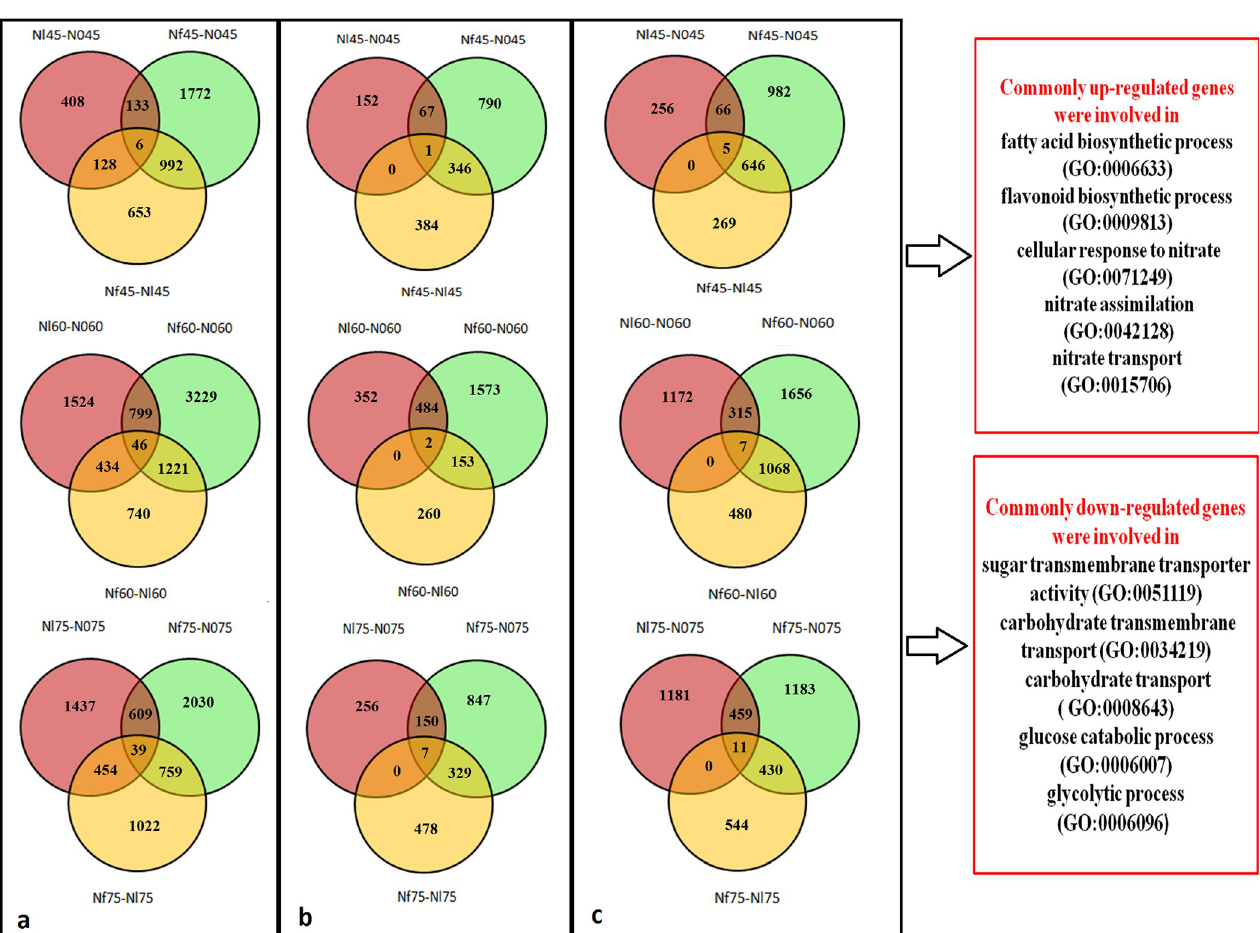
Fig 5. Venn diagram of the number of genes in the Nf-N0 (N0 compared to Nf), Nf-Nl, and Nl-N0 groups at 45, 60, and 75 days after transplanting (DAT). (a) All differentially expressed genes (DEGs), (b) upregulated DEGs, (c) downregulated DEGs. https://doi.org/10.1371/journal.pone.0273495.g005 The topGO enrichments showed that the biological processes “phosphate ion transmem- brane transport” and “phosphate ion transport” were the most abundant functional groups enriched by downregulated DEGs in N0 vs. Nf at 45 and 75 DAT as well as in Nl vs. Nf at 45 DAT. The terms “response to chitin” and “phosphate ion transport” were obviously enriched by downregulated DEGs in N0 vs. Nf at 60 DAT, and at the same time, the terms “response to chitin”, “response to wounding”, “phosphate ion transport”, and “phosphate ion transmem- brane transport” were enriched in Nl vs. Nf by downregulated DEGs. In addition, at 75 DAT, the process “response to water deprivation” was enriched significantly by downregulated DEGs in Nl vs. Nf. Moreover, wounding and deprivation processes were downregulated under Nl treatment at 60 and 75 DAT, Furthermore, “glucose − 6 − phosphate transport” and “phos- phoenolpyruvate transport” were enriched by upregulated DEGs under N0 treatment at 45 DAT. The term of “transcription, DNA-templated” was markedly enriched by upregulated DEGs under N0 treatment at 60 and 75 DAT. The processes of cholesterol metabolic, lipid catabolism, and nucleoside or amino acid transport were enriched significantly by upregulated DEGs under Nl condition at 45, 60, and 75 DAT (S3 Fig, S7 Table).